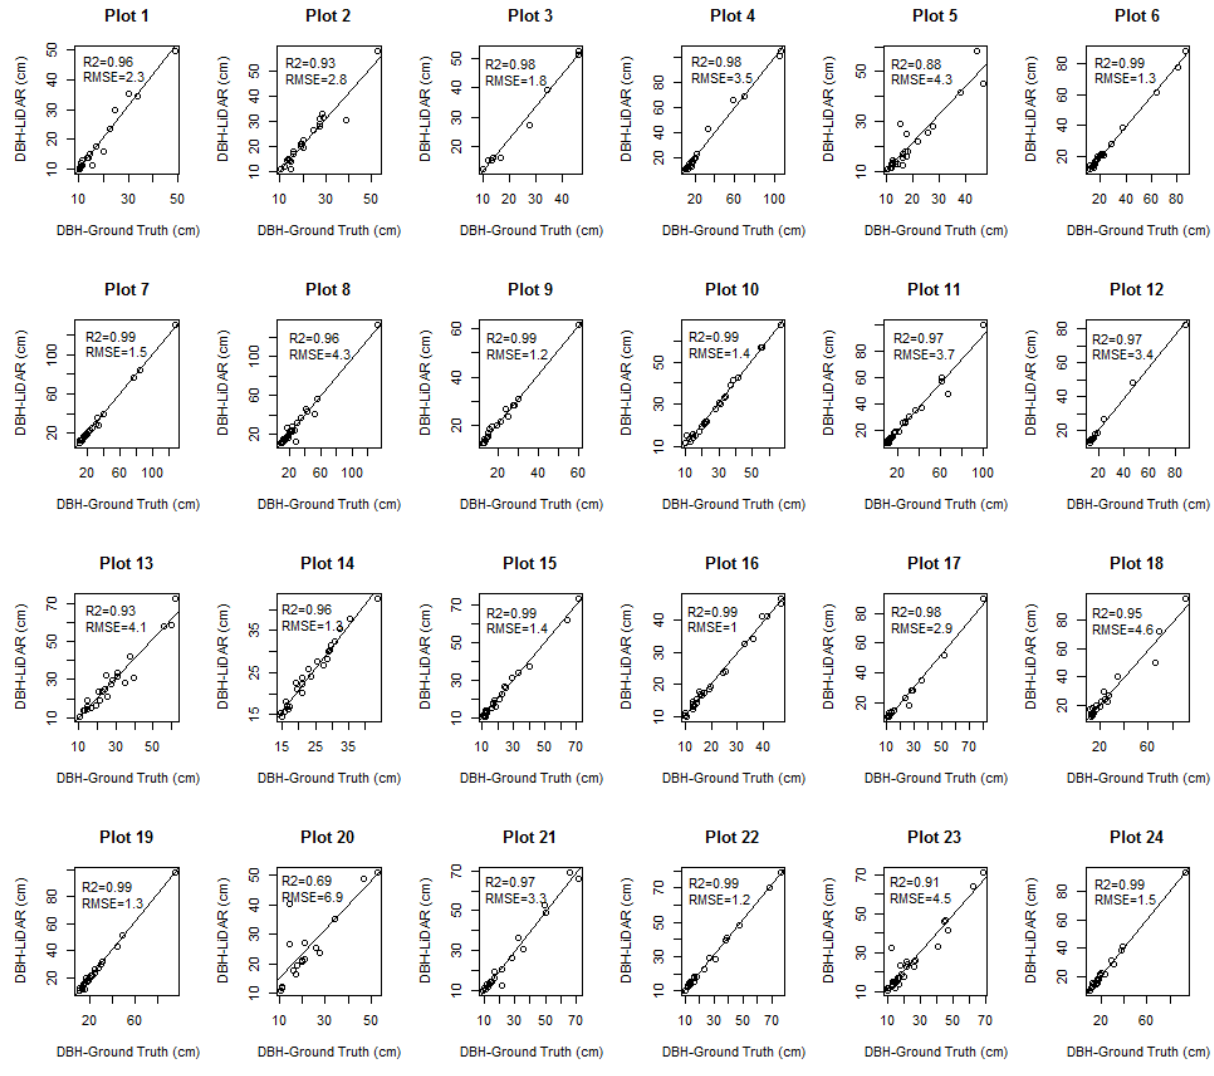
Figure 10. Plot level comparison between DBHs from field and T-LiDAR